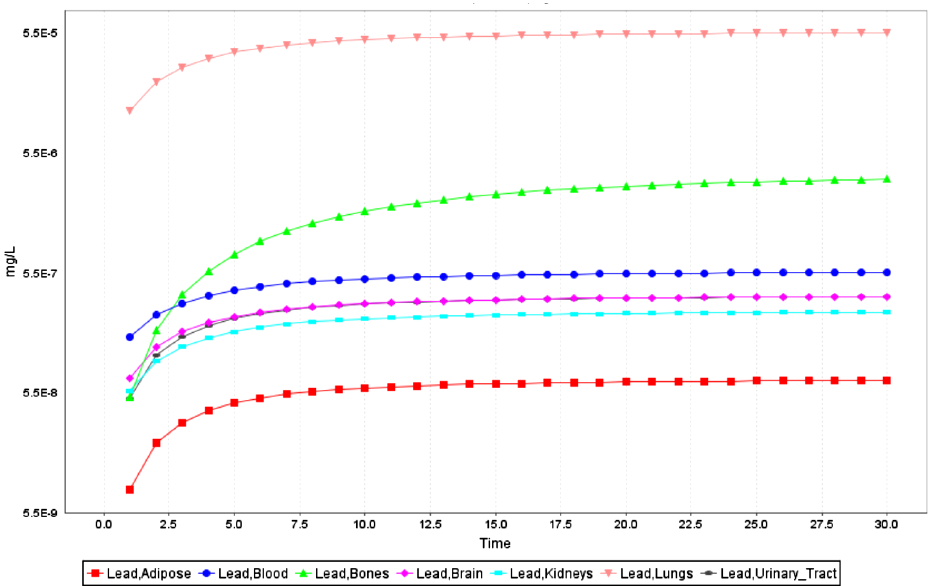
Figure 12. Pb concentration in the most contaminated compartments in subject 1, E group (logarithmic scale in y